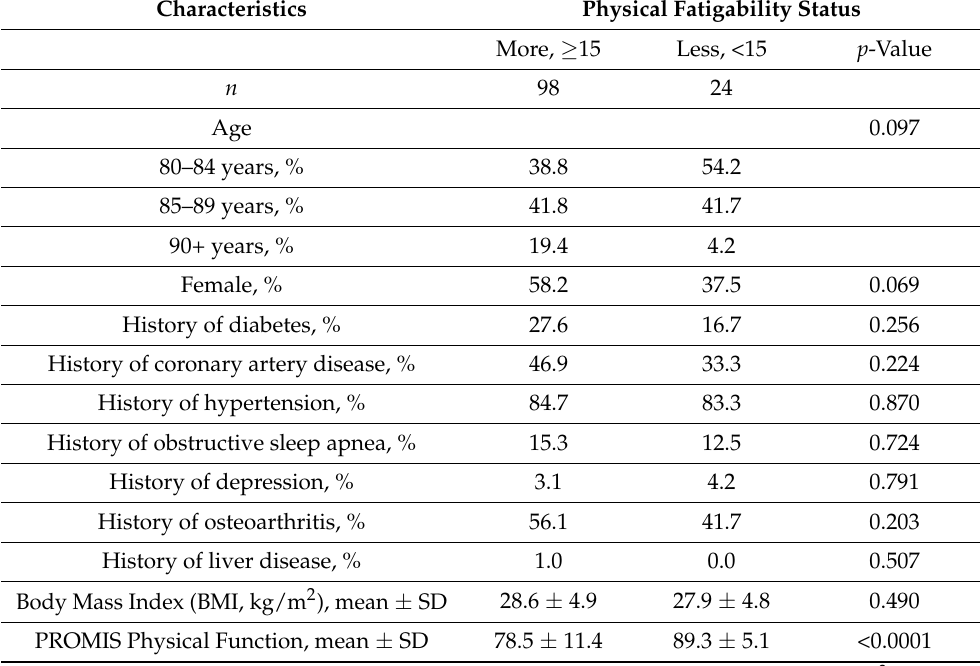
Table 1. Demographic and health-related characteristics data in a subset of 122 oldest-old participants from the Geisinger Rural Aging Study according to perceived physical fatigability status: Pittsburgh Fatigability Scale